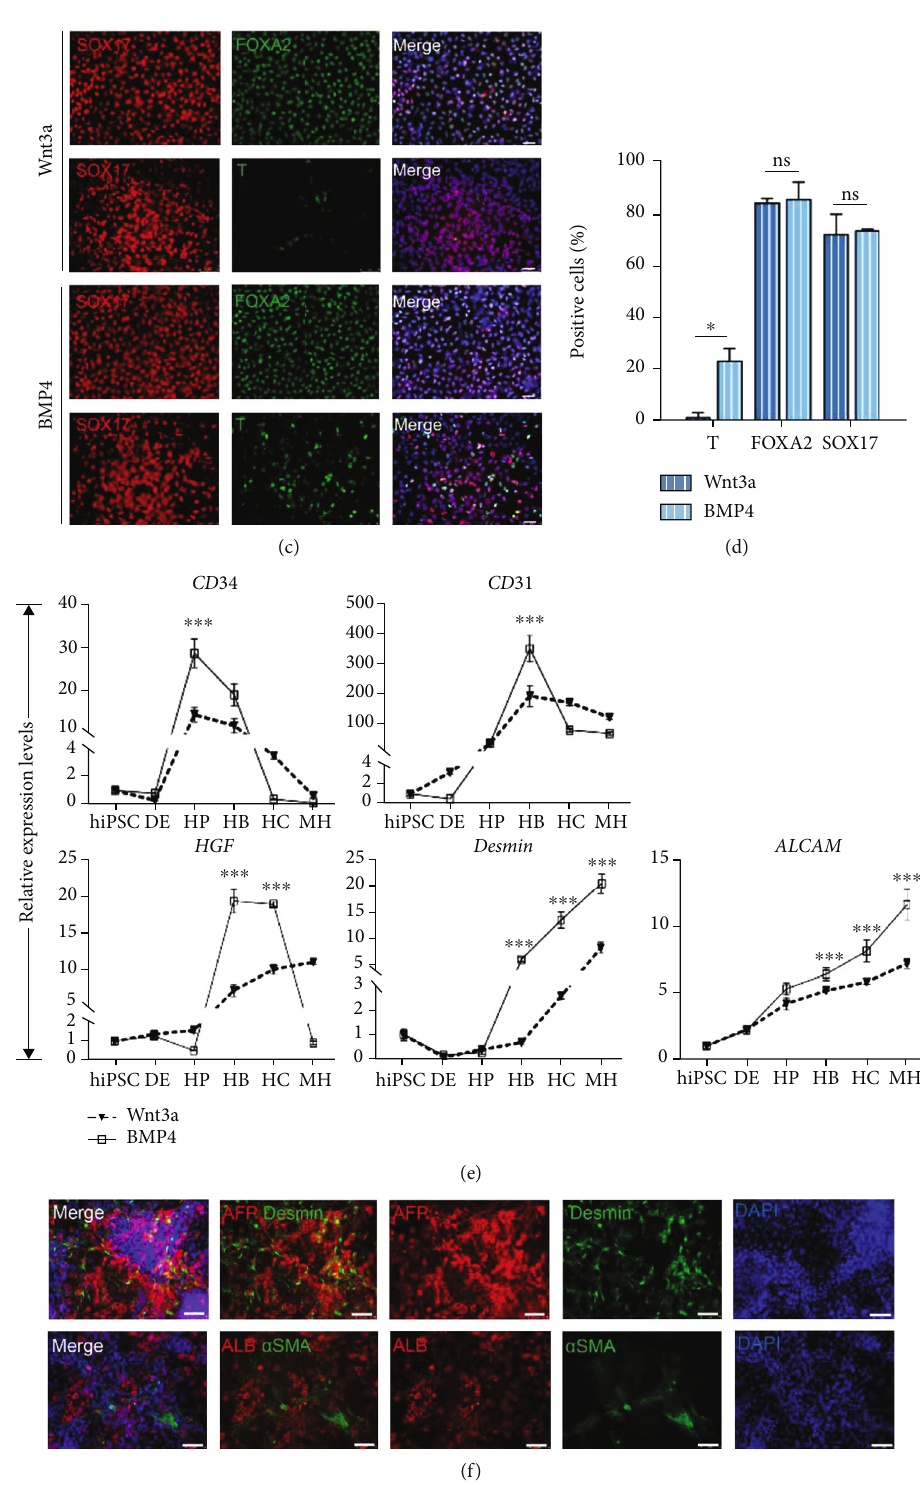
Figure 2: Codi ff erentiation of hepatocytes and nonparenchymal cells. (a) Schematic representation of the hepatocyte di ff erentiation procedure during day 0 to day 30. The bright fi eld images showed the sequential morphological changes (days 0-30) of hiPSC di ff erentiation into hepatocytes. Scale bars, 50 μ m. (b) Quantitative PCR analysis and immuno fl uorescence (c, d) showed that addition of BMP4 into endoderm medium resulted in main endoderm and a small part mesoderm commitment. Scale bars, 50 μ m. ∗ p < 0 : 05 , ∗∗ p < 0 : 01 , ∗∗∗ p < 0 : 001 , and n = 3 . (e) Quantitative PCR analysis showed endothelial cell marker gene expression levels during hepatocyte di ff erentiation. ∗ p < 0 : 05 , ∗∗ p < 0 : 01 , ∗∗∗ p < 0 : 001 , and n = 3 . (f) Immuno fl uorescence image showed endothelial cells in hepatic progenitors and hepatoblast stage in the BMP4 group. Scale bars, 50 μ